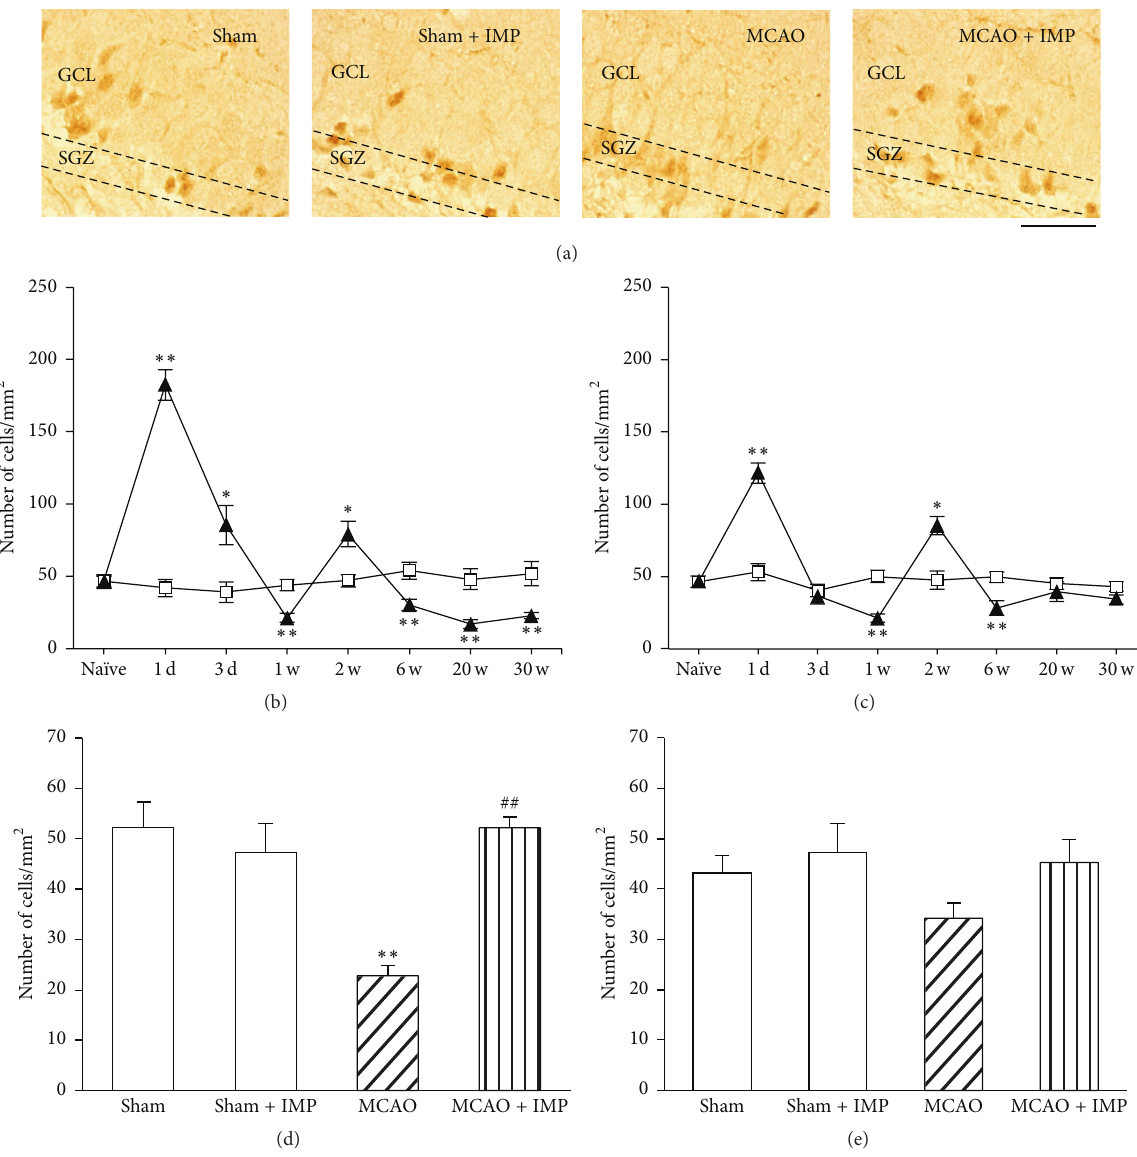
Figure 9: Analysis of the number of Bcl-2 𝛼 immunopositive cells in the ipsilateral GCL and SGZ. (a) Typical images of the slices taken at 30 weeks after MCAO. Scale bar indicates 50 𝜇 m. (b, c) Time course changes of Bcl-2 𝛼 immunopositive cells after MCAO in GCL (b) and SGZ (c). Symbols used are as follows: open square, sham; closed triangle, MCAO. Statistical significance was evaluated with two-way = 40.3 , 𝐹 = 20.8 , 𝐹 = 48.7 , 𝑡 = 12.4 , 𝑡 = 3.15 , ANOVA followed by unpaired 𝑡 -test at each time point (GCL: 𝐹 ( ( group )1 ( time ∗ group )7,64 (1 d ) (3 d ) time )7 = −5.54 , 𝑡 = 3.31 , 𝑡 = −4.16 , 𝑡 = −5.73 , and 𝑡 = −5.44 ; SGZ: 𝐹 = 23.1 , 𝐹 = 2.36 , 𝐹 = 18.2 , 𝑡 (1 w ) (2 w ) (6 w ) (20 w ) (30 w ) ( time )7 ( group )1 ( time ∗ group )7,64 = 7.36 , 𝑡 = −5.38 , 𝑡 = 2.90 , and 𝑡 = −3.64 ; ∗ 𝑃 < 0.05 and ∗∗ 𝑃 < 0.01 versus sham). (d, e) Analysis of the effect of IMP 𝑡 (1 d ) (1 w ) (2 w ) (6 w ) (20 mg/kg/day for 29 weeks) on the number of Bcl-2 𝛼 immunopositive cells at 30 weeks after MCAO in GCL (d) and SGZ (e). Statistical = 11.9 ; 𝐹 = 1.84 ; ∗∗ 𝑃 < 0.01 significance was evaluated with one-way ANOVA followed by Tukey-Kramer post hoc test ( 𝐹 ( ( SGZ )3,16 GCL )3,16 versus sham [IMP( − )]; ## 𝑃 < 0.01 versus MCAO; 𝑁 = 5 /group).